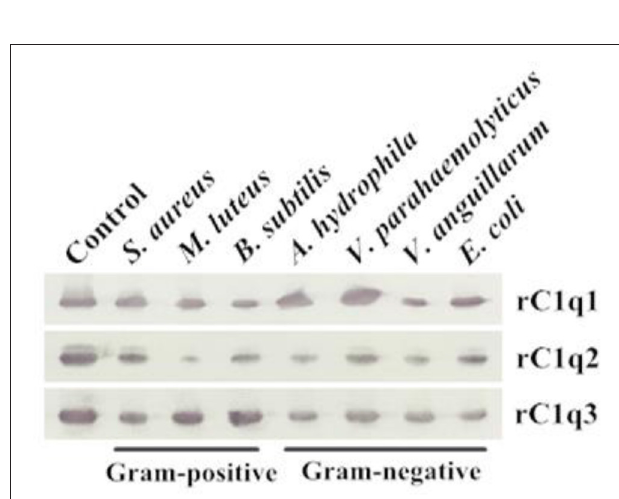
FIGURE 8 | Direct binding of rC1q1 to rC1q3 to seven bacterial strains. The recombinant proteins were incubated with microorganisms first and then washed four times with PBS. Binding activity was confirmed using Western blot with anti-His rabbit mAb against recombinant C1q proteins with His-tag.